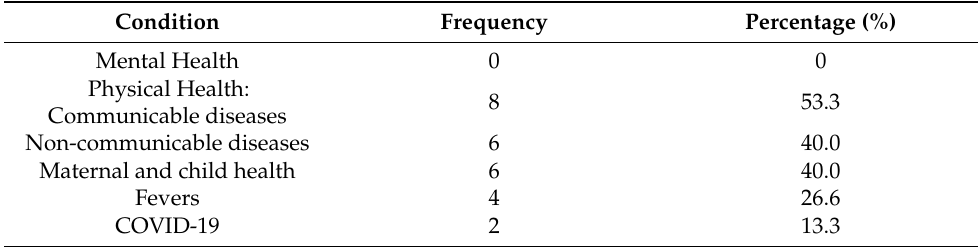
Table 1. Occurrence of health conditions and disease burden in